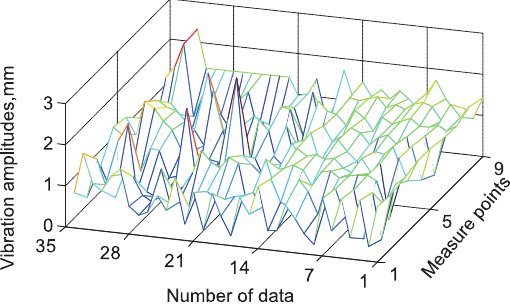
Fig. 3. 3-D graphics of the vibration signals for rotor normal. Fig. 4. 3-D graphics of the vibration signals for rotor imbalance.